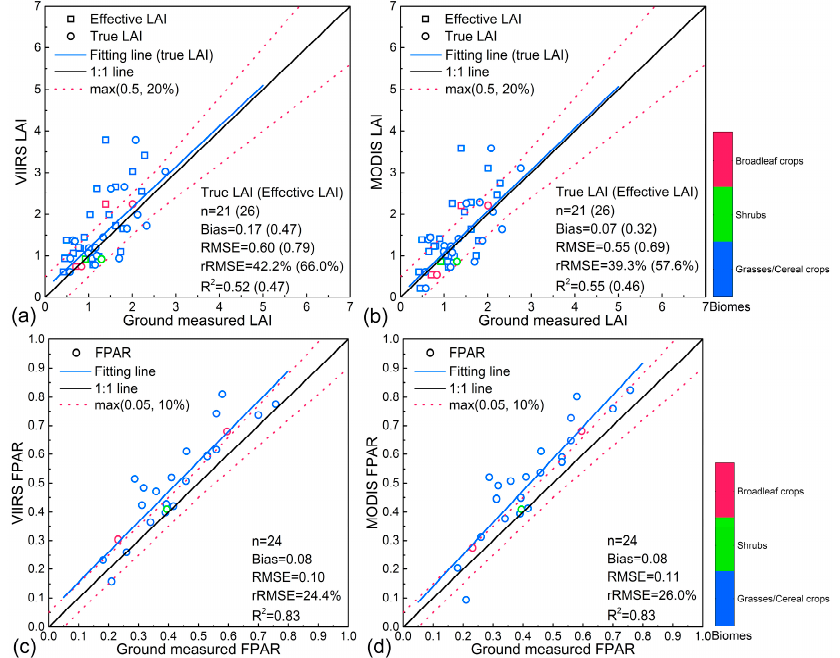
Figure 8. Comparison between ground measurements and products. ( a , b ) for VIIRS and MODIS LAI and ( c , d ) for FPAR. The 3 km × 3 km sites dominated by different biome types are depicted by different colors. Circles (squares) in panel ( a , b ) represent ground LAI measurements corrected (not corrected) for the clumping effect. The blue and black solid lines represent the overall fit and 1:1 line, respectively. The red dashed lines show the GCOS specifications boundaries (max (0.5, 20%) for LAI and max (0.05, 10%) for FPAR). Note that LAI was only distributed in relatively lower domains (~2.5), the RMSE is better than the rRMSE to show LAI product accuracy based on the accuracy requirement (max (0.5, 20%)) from